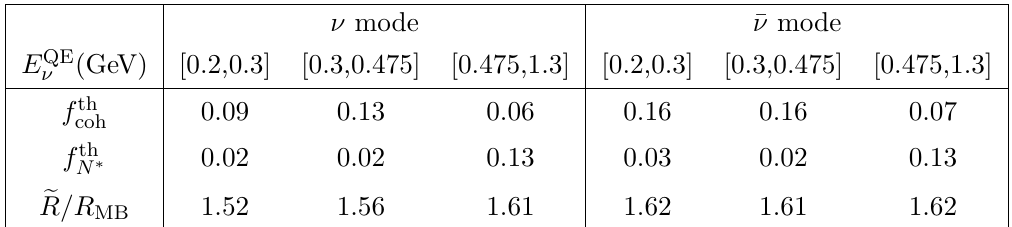
and f th from table 2 of ref. [16] in three ranges of reconstructed N ∗ coh